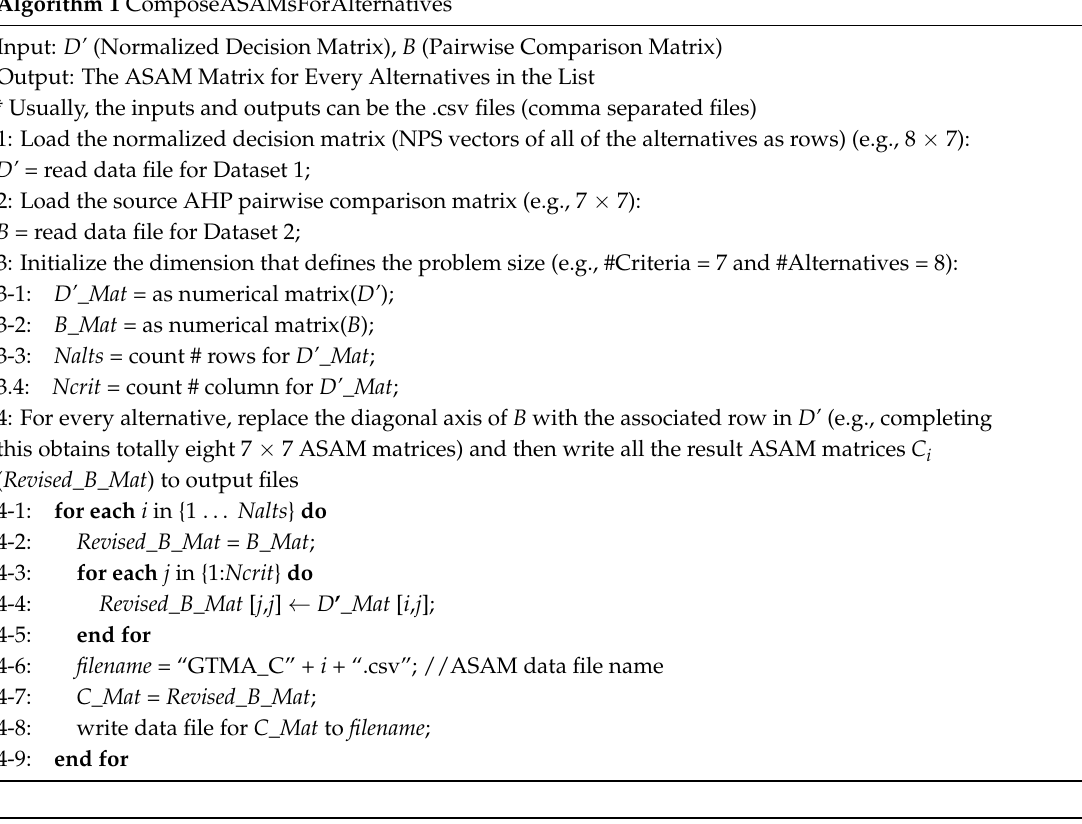
Algorithm 1 ComposeASAMsForAlternatives